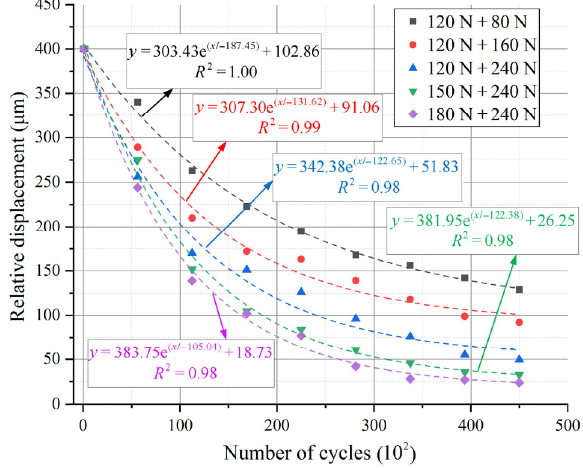
Fig. 11 Evolution trends of relative slip under different loading conditions.